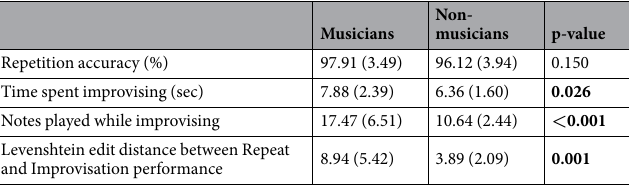
Table 2. Behavioral performance during fMRI task (means and standard deviations